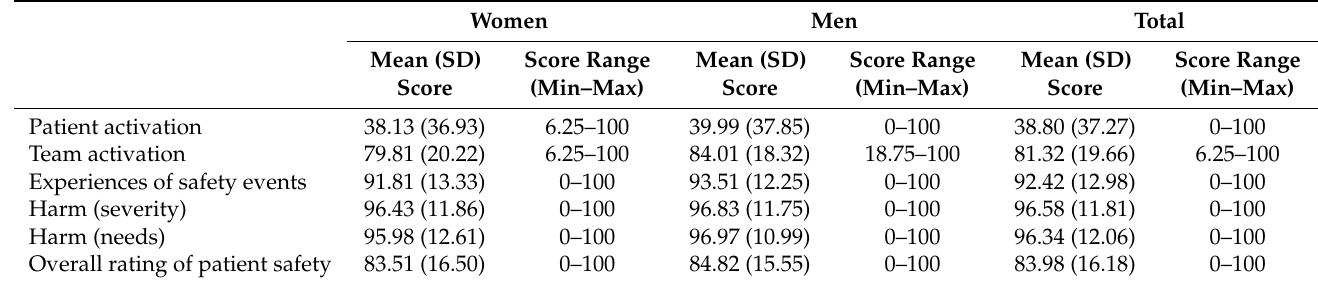
Table 2. Patient-reported patient safety with the PREOS-PC